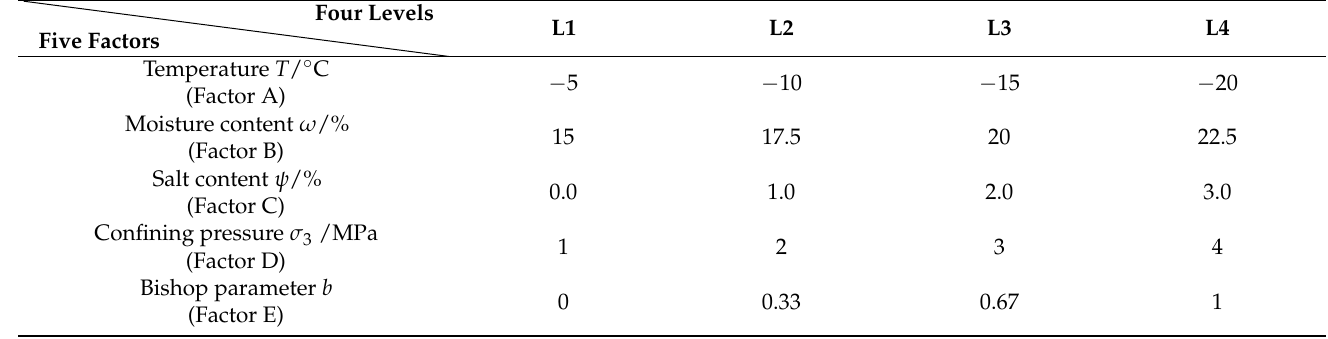
Table 2. True triaxial test factors of calcareous clay and their corresponding levels. (Note: The salt content in this table was the salt content in 100 mL of pure water, that is, the mass percentage of anhydrous CaCl 2 [23]).